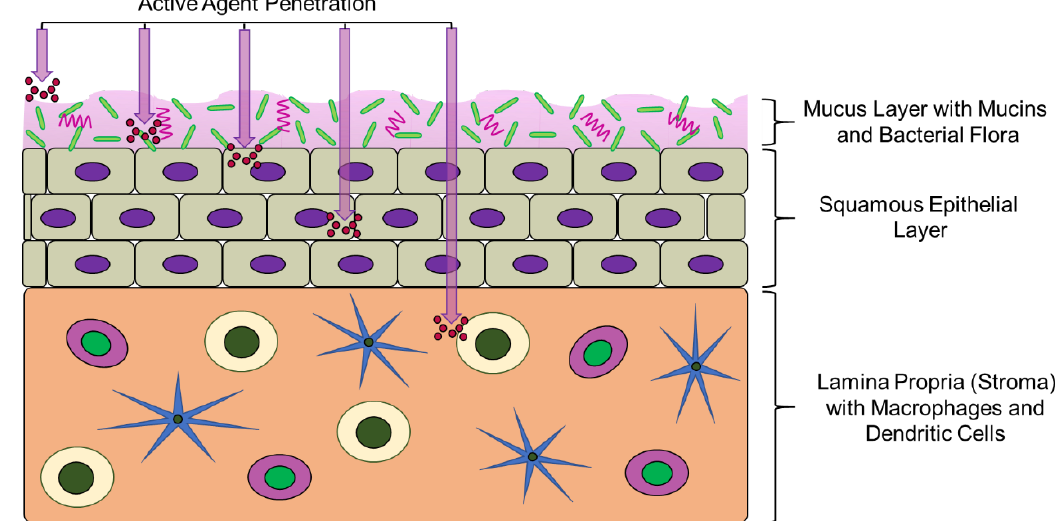
Figure 1. Schematic depicting the structure and specific layers of the vaginal mucosa that can act as a barrier to active agent transport (not to scale). The mucus layer of the female reproductive tract (FRT) frequently sheds and can immobilize active agents (shown in red), leading to decreased efficacy of the administered agents. The bacterial flora normally present within the FRT can also metabolize and degrade agents, further contributing to decreased efficacy. Last, the squamous epithelium can hinder transport to underlying immune cells present near the epithelial surface and/or in the lamina propria.